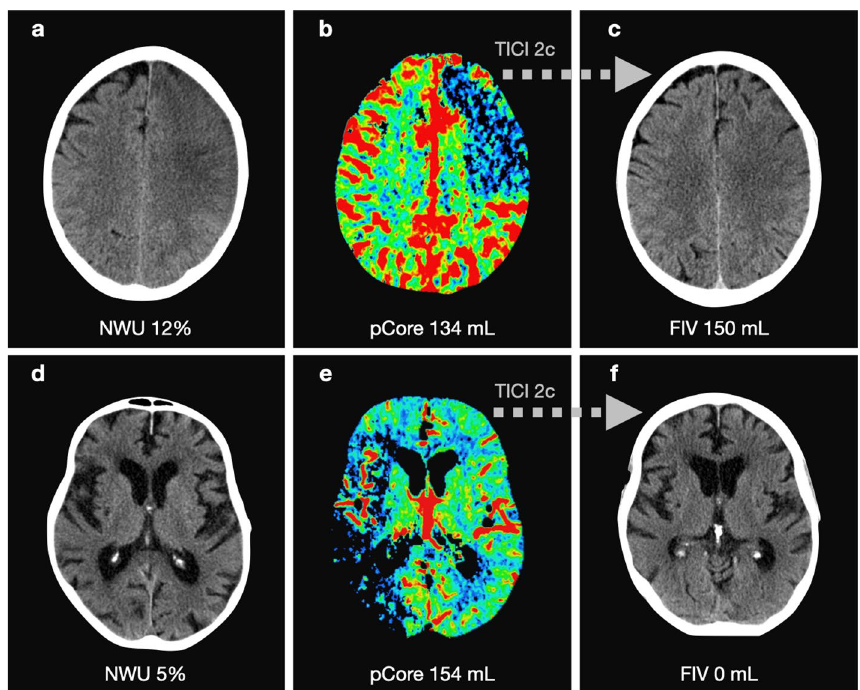
Figure 3. Examples of patients with high ( A – C ) and low ( D – F ) NWU and their association with pCore overestimation. Both patients presented within a similar time frame and achieved near-completed